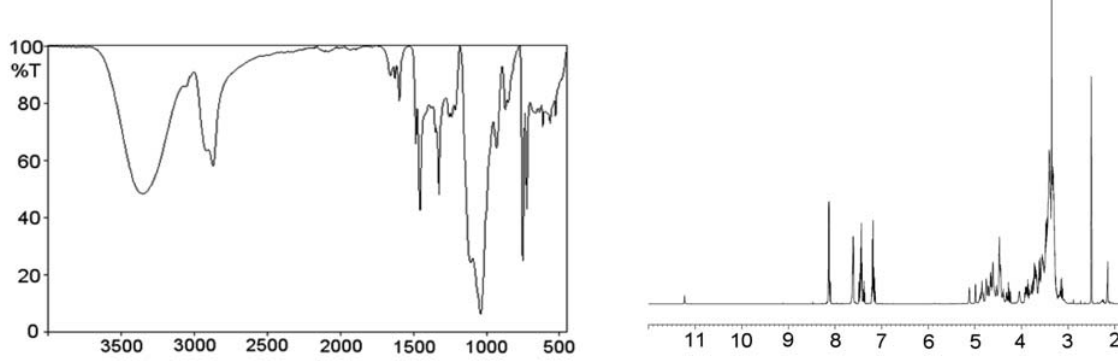
Fig. 4. 1 H-NMR spectrum of semiproduct obtained from C : GL = 1 : 7 molar